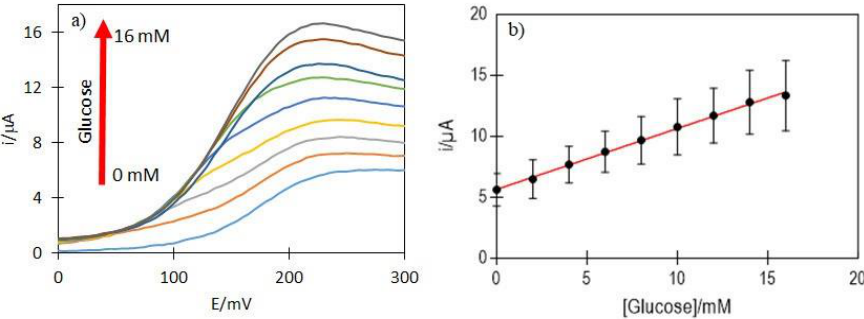
Figure 10. Increase in the oxidation current of Ferrocene-methanol, as a function of the glucose added to cell ( a ). Calibration curve obtained from glucose determination on three electrodes modified with TMPyP/GSH-CdTeQD/GOx ( b ).